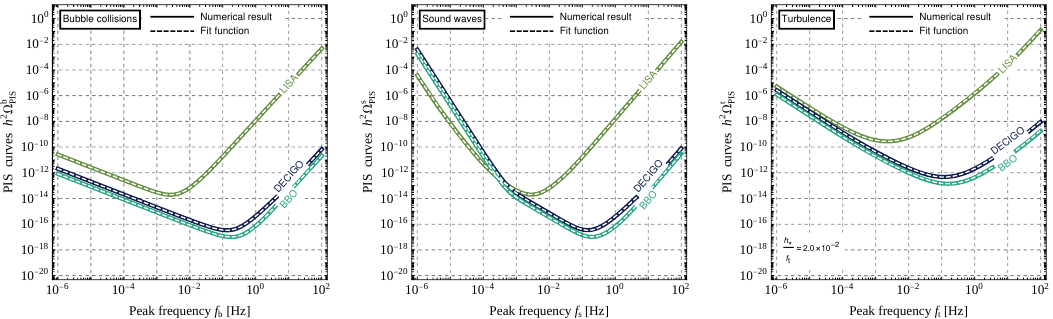
Figure 9 . Numerical results and fit functions for the PISCs in the b-, s-, and